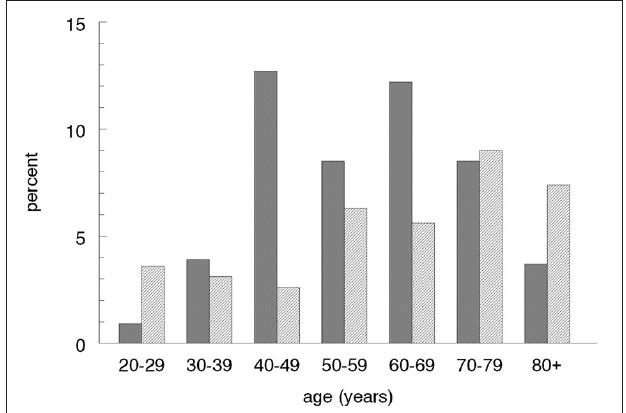
FIGURE 1 | Age and gender distribution in individuals with daily or frequent symptoms of cough. Data presented in percentage of the total population. Dark bars = females.